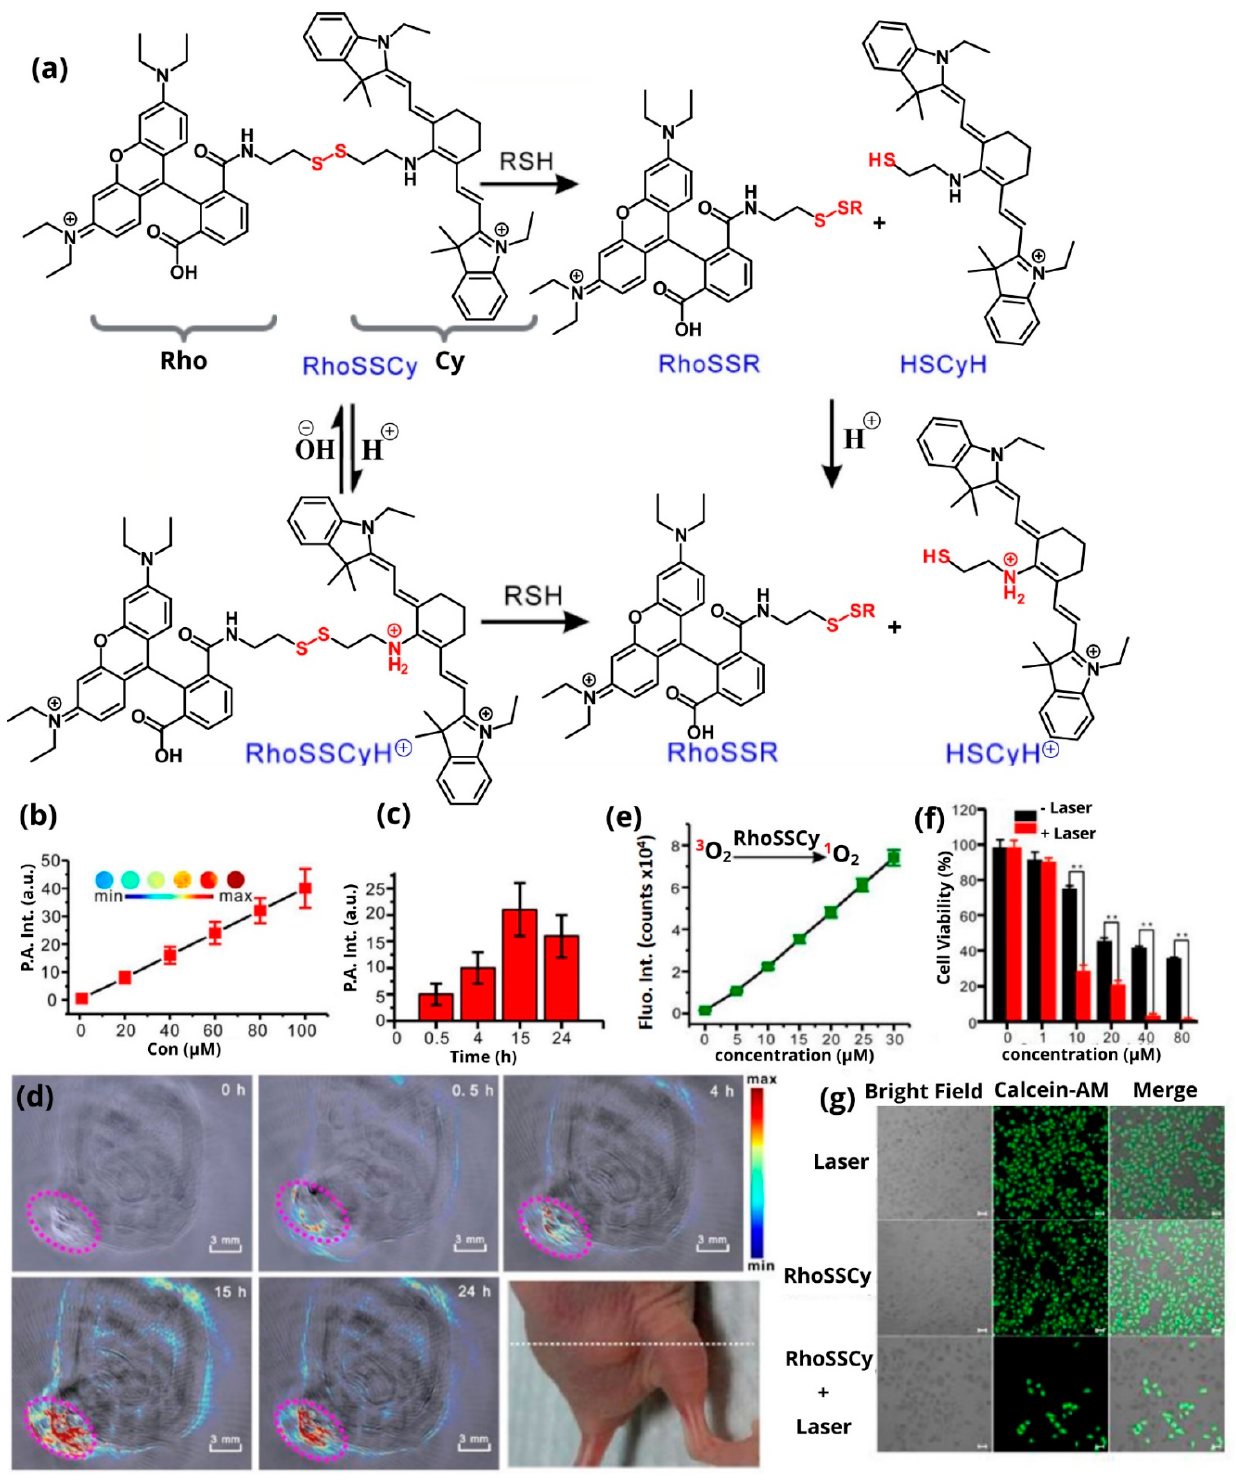
Figure 14. ( a ) Schematic representation of how RhoSSCy interacts with thiols and pH; ( b ) the correlation between PA intensity and RhoSSCy concentration; ( c ) graphic of PA signal as a function of time; ( d ) PA imaging of a tumor-bearing nude mouse, as well as real-time photos of the agent’s accumulation point; ( e ) graph showing the linear relationship from the release of ROS and RhoSSCy concentration; ( f ) images of MCF ‐ 7 cells visualized by fluorescence. Viable cells were stained green via calcein ‐ AM dye. Bars, 25 μ m; and ( g ) MCF ‐ 7 cell’s survivals using RhoSSCy in different concentrations after PDT. Adapted with permission from [140], Theranostics, 2017.